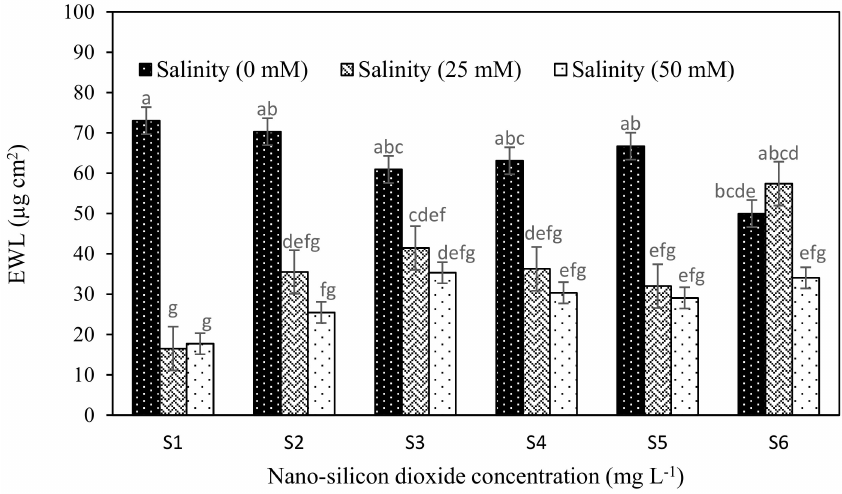
Figure 2. EWL concentrations of strawberry in three levels of salinity 0 mM (black bars), 25 mM (grey bars) and 50 mM (white bars) treated with di ff erent levels nano-silicon dioxide. Mean values with the same letter are not significantly di ff erent by least significant di ff erences (LSD) test at p ≤ 0.01.